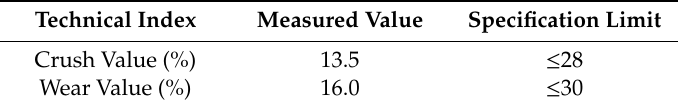
Table 5. Crushing and wear values of the coarse